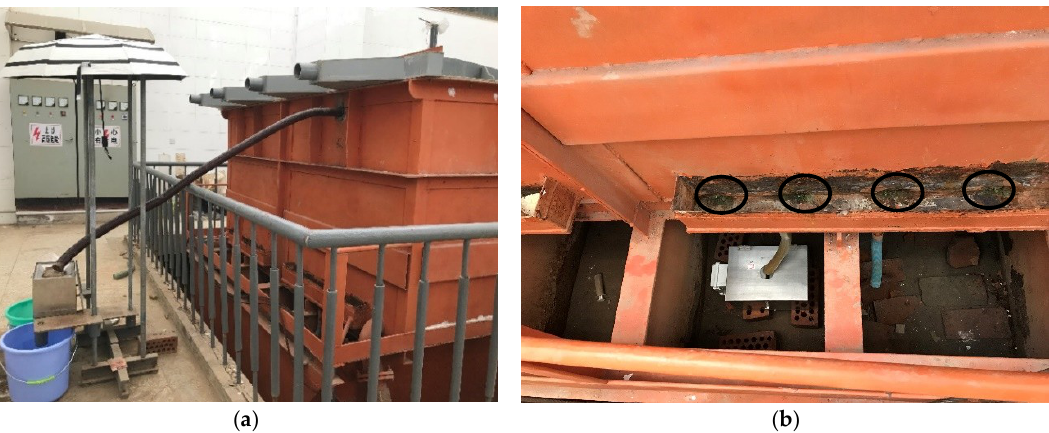
Figure 3. ( a ) Device for collecting surface runoff (SR). The umbrella is used to prevent the rainfall from splashing into the tipping bucket. ( b ) Device for collecting subsurface runoff (SSR). There are four small holes at the bottom of the soil tank, also one hole at the bottom of the rectangular collection tank.